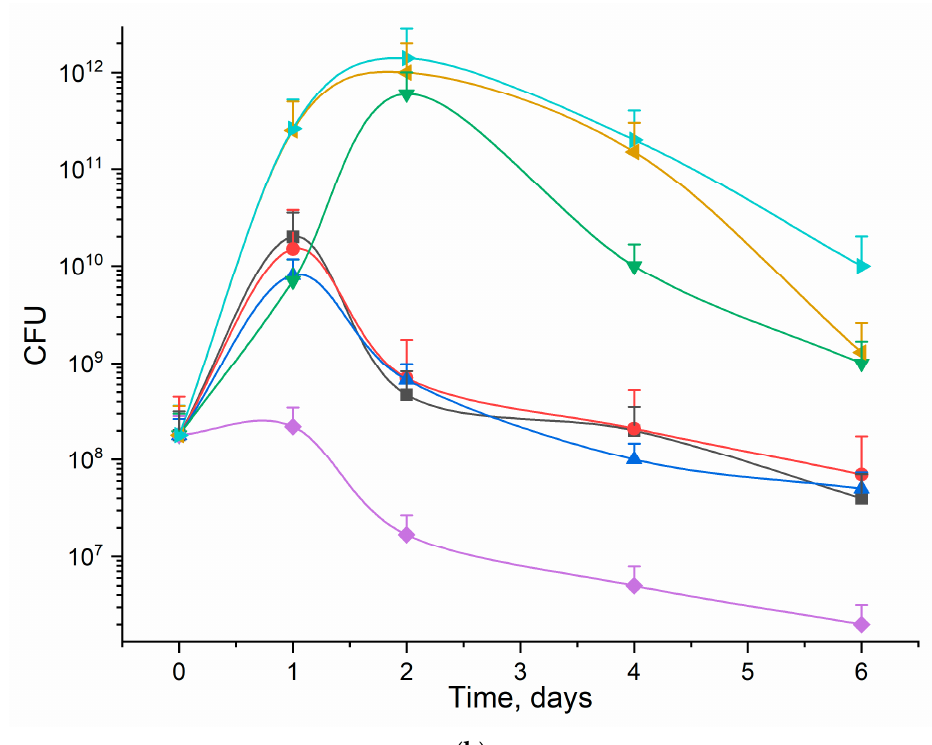
Figure 6. Antibacterial activity of Rif (1 μ g/mL) in free form and loaded into HPCD-PEI1.8-triMan, enhanced with eugenol (0.1 mg/mL): ( a ) absorbance of samples (in terms of the diluted samples (absorption was determined in aliquots diluted 4–10 times)) correlated with CFU, and ( b ) CFU dependences determined by quantitative seeding on petri dishes. Rif: polymer mass ratio = 1:10. pH 7.4 (0.01 M PBS), 37 °C.